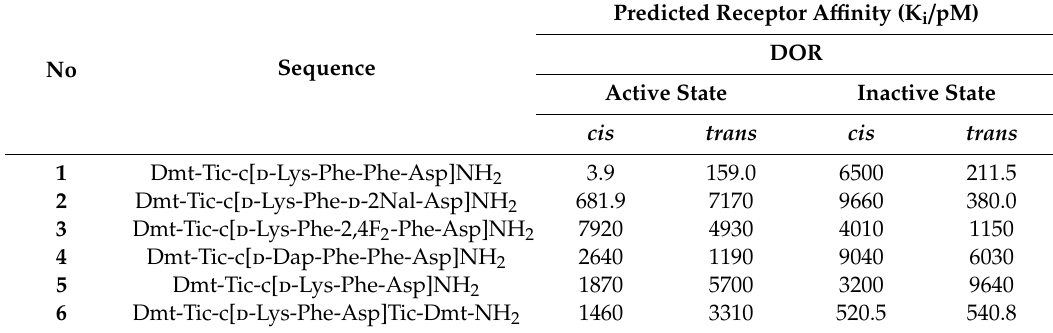
Table 4. Predicted binding free energies and inhibitory constants of bivalent opioid ligands with the active and inactive